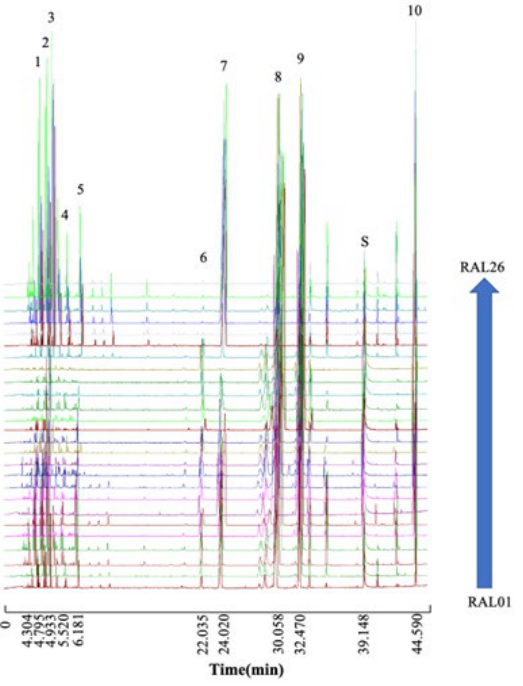
Figure 2. GC-MS chromatogram of 26 batches of RAL from different regions. (1) α -guaiene; (2) modephene; (3) berkheyaradulene; (4) caryophyllene; (5) γ -elemene; (6) elemol; (7) atractylon; (8) hinesol; (9) β -eudesmol; (S) ISTD:1-hexadecanol; (10) atractylodin.